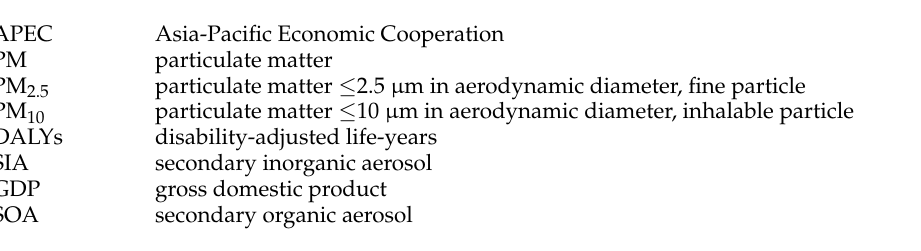
Table S1: Characteristics (mean ± SD) and comparison of particulate matter in various monitoring sites, Table S2: Estimated proportion and numbers of deaths attributed to PM pollution pre, during and post APEC using by AirQ+